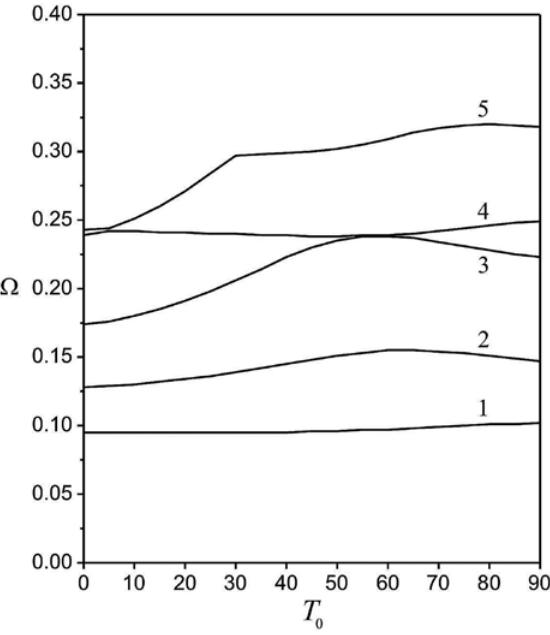
= 30 ° ) for the first ( T 0 1